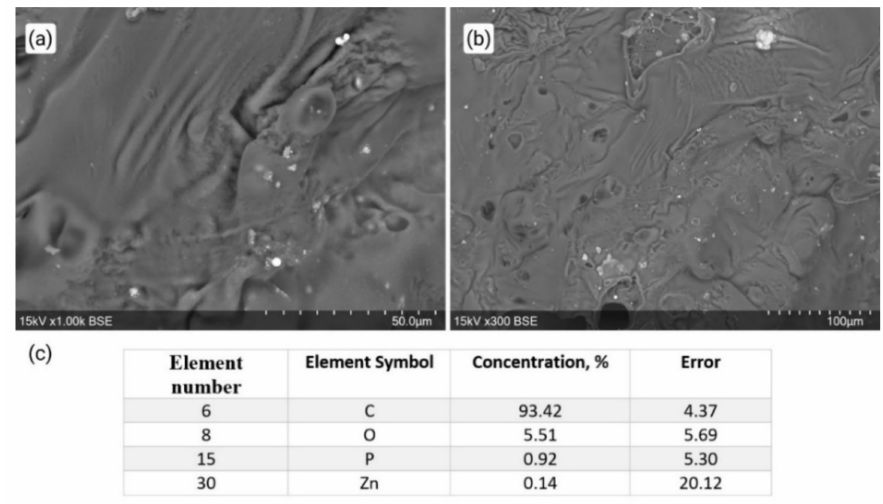
Figure 2. SEM images ( a , b ) and elemental analysis from energy dispersive X-ray spectrometry ( c ) for an object 3D-printed from the photopolymer composition with concentration of ZIF-8 5